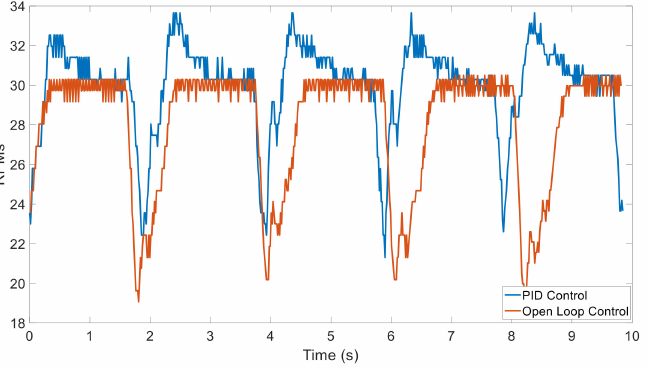
Figure 16. Graph showing the rpms measured by the encoder when in PID control and in the open loop control.